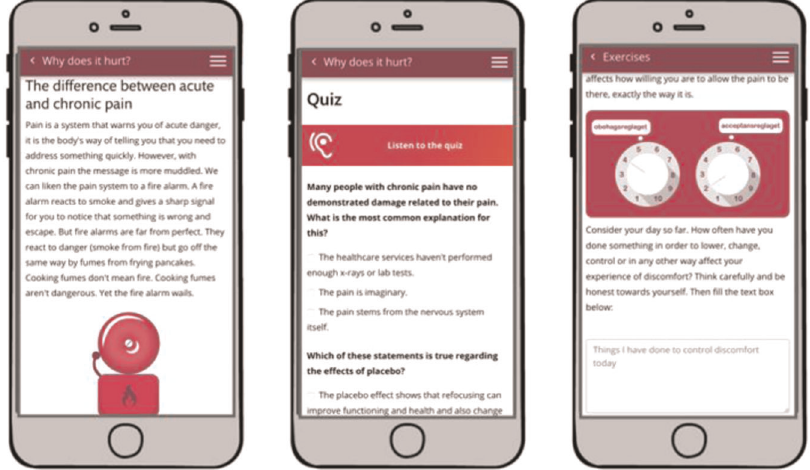
Fig. 9 Screenshot of patient interface, educational content, and